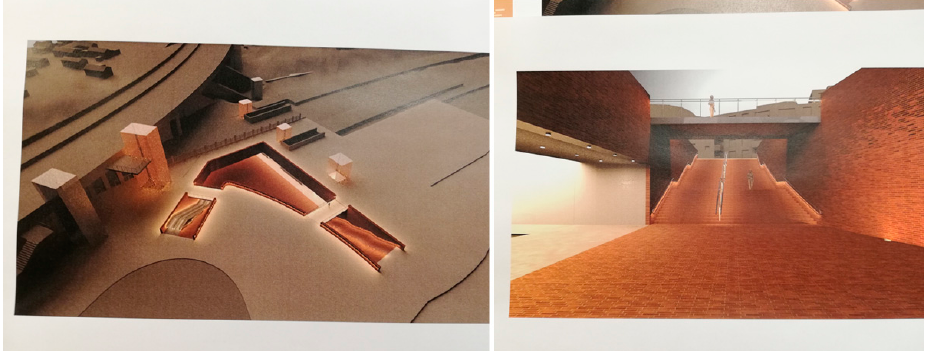
Figure 5. Renderings showing evening light conditions of the concourse.